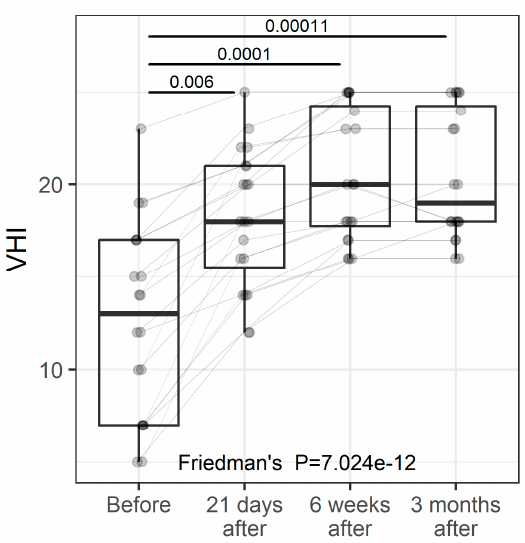
Figure 3. VHI at study entry and follow-up visits (individual values and summary statistics). Individual values are represented by points joined by lines. Summary statistics are shown using boxplots. The middle line of the boxplot is median, the lower and upper hinges correspond to the first and third quartiles (the 25th and 75th percentiles). The upper whisker extends from the hinge to the largest value (no further than 1.5*IQR from the hinge, IQR is the interquartile range—distance between the first and third quartiles). The lower whisker extends from the hinge to the smallest value (no further than 1.5*IQR of the hinge). p -values were determined using Friedman’s test, followed by pairwise post hoc Wilcoxon test with FDR adjustments for multiple testing